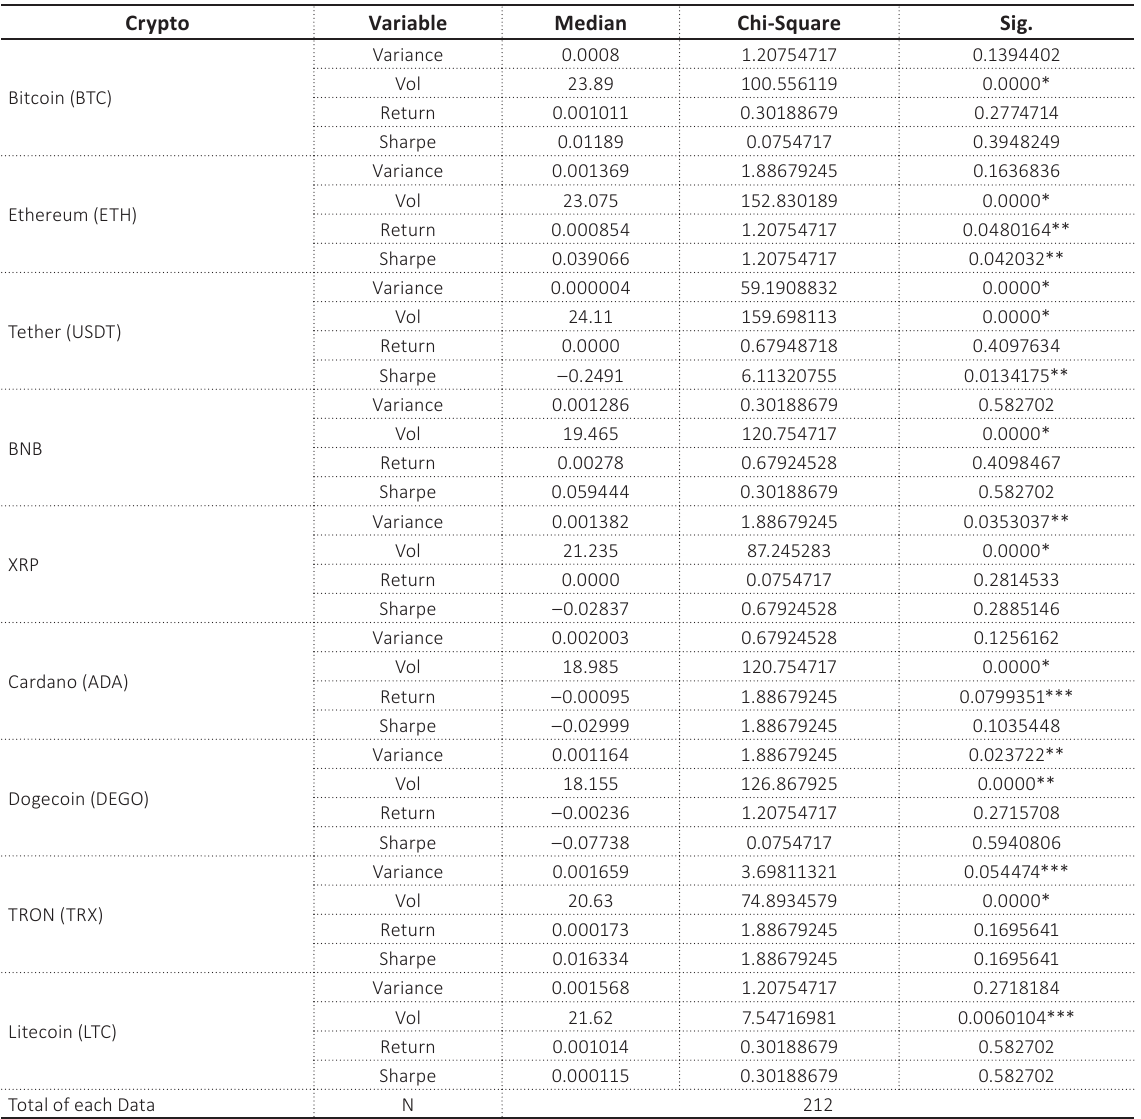
Table 3. Kruskal-Wallis, each one Crypto Crypto Variable Median Chi-Square